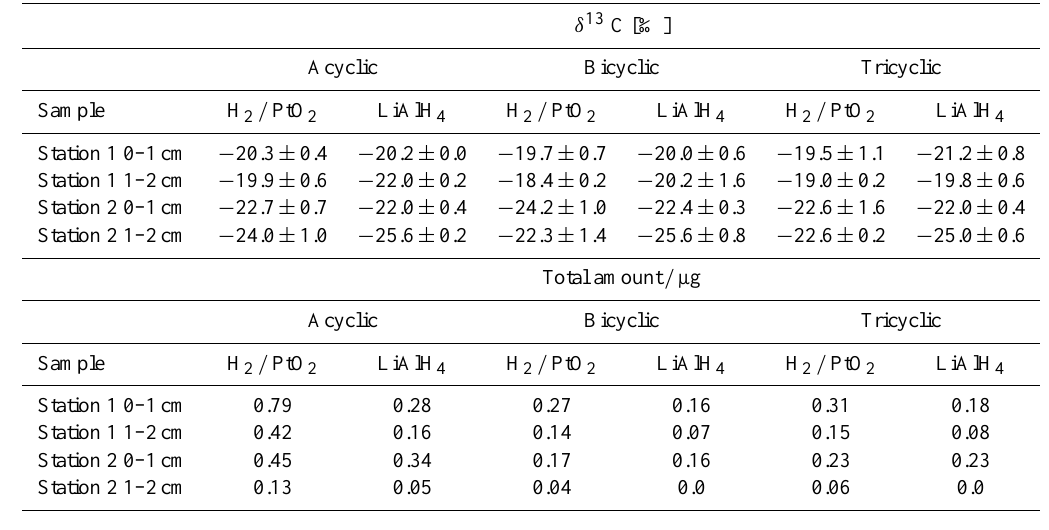
Table 1. δ 13 C values of the acyclic, bicyclic, and tricyclic biphytanes obtained via H 2 / PtO 2 and LiAlH 4 reduction of alkyliodides formed via HI ether cleavage.